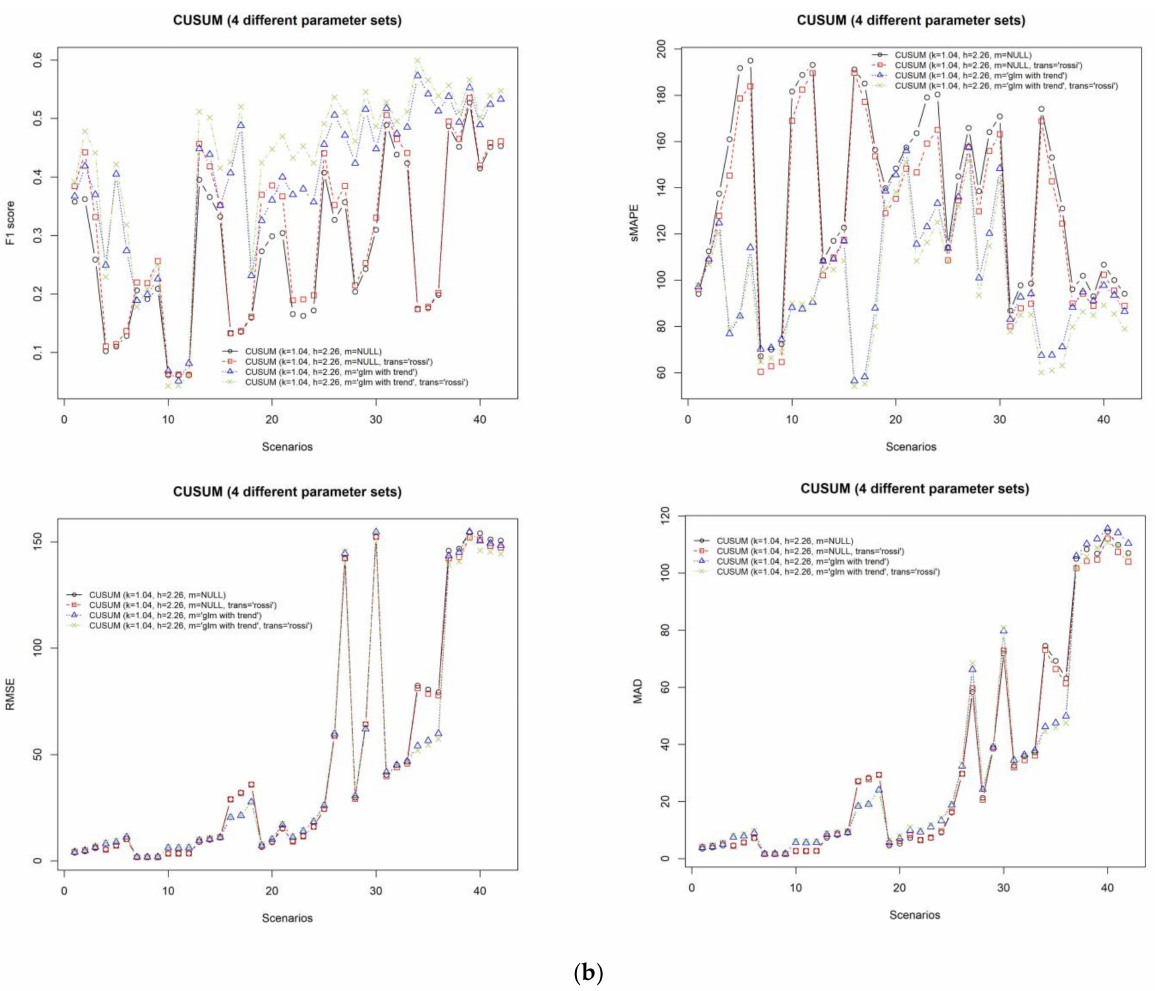
Figure 3. ( a ) The results of the four different CUSUM algorithms with different sets of parameters in terms of sensitivity, specificity, PPV, and NPV across the all scenarios. ( b ) The results of the four different CUSUM algorithms with different sets of parameters in terms of F1 score, sMAPE, RMSE, and MAD across the all scenarios. CUSUM: the CUmulative